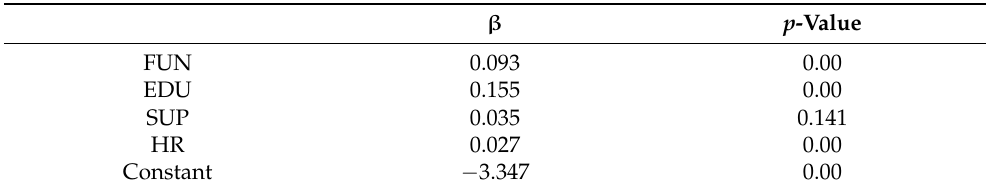
Table 14. Logistic regression results for COM6 (previous start-up experience of the founders) inde- pendent